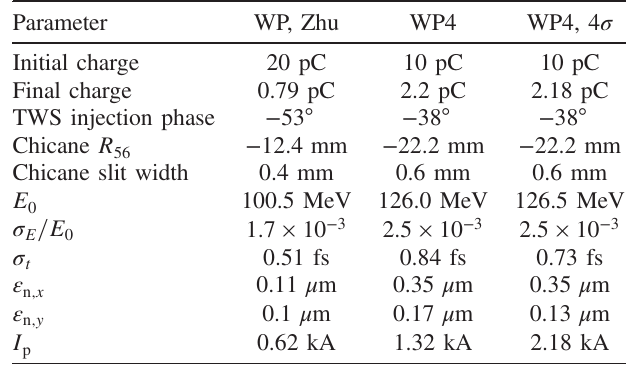
TABLE III. Beam parameters of different ARES working points (WP) 1.75 m downstream of the chicane exit ( z ¼ 30 . 5 m). WP, Zhu taken from [37], WP4 obtained from ASTRA and IMPACT - T simulations (no LPSS interaction). WP4, 4 σ refers to WP4 þ LPSS optimization with a 4 σ ROI. TWS: traveling wave